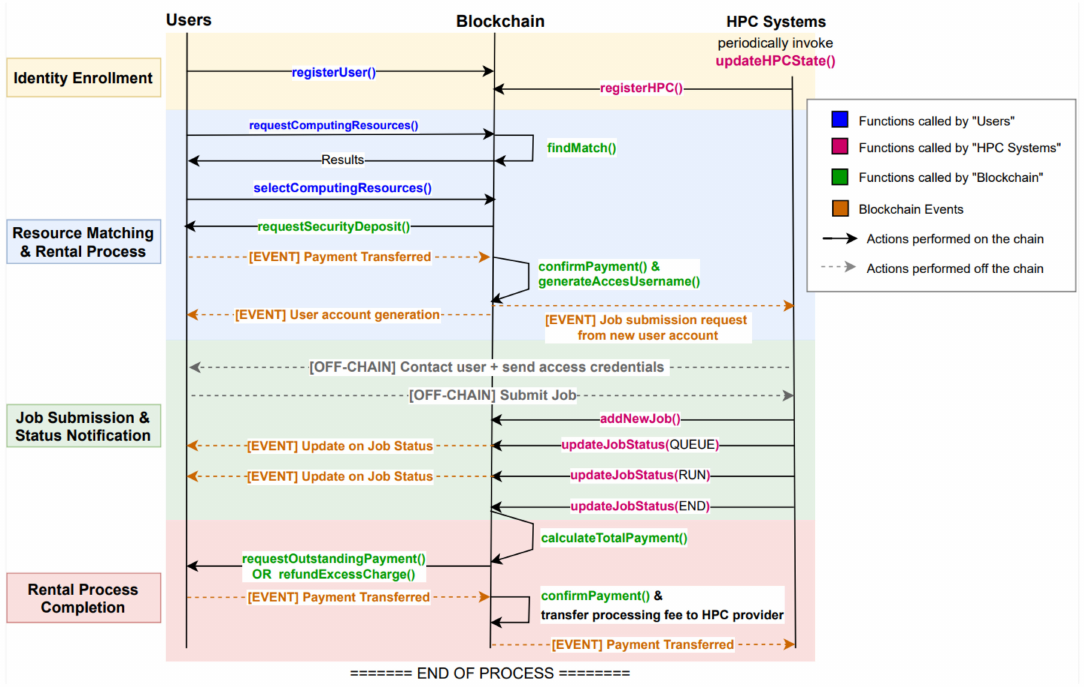
Figure 4. Communication